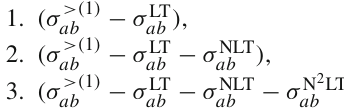
Fig. 2 Difference of the total cross sections gg → Hg channel (right pane). Same legend as in Fig. 1. The corresponding values of a = ( 1 , n , m ) ˆ G The